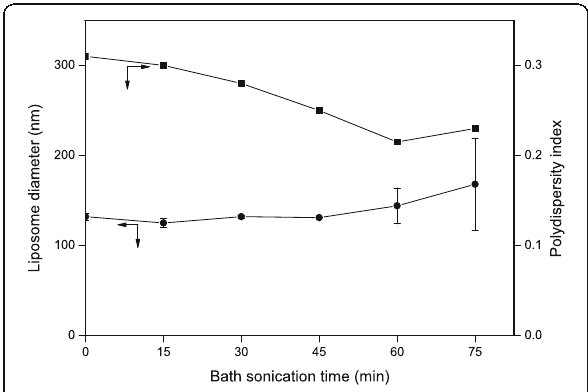
Fig. 3 Effects of bath sonication time on diameter and polydispersity index of DOX- and ERL-encapsulated nanoliposomes ( n =3, the data are presented as mean±SEM)